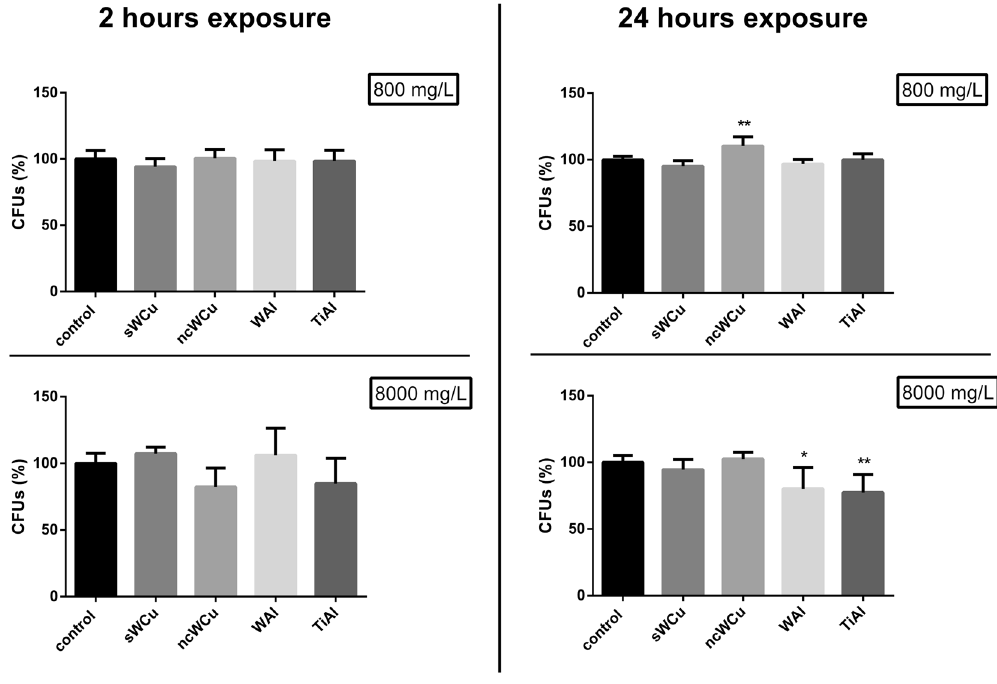
Figure 4. Colony forming units (CFUs) of S. cerevisiae cells exposed to different metal powders at two exposure times (2 and 24 h) and two concentrations (800 and 8000 mg/L). Results are expressed as the percentage (%)